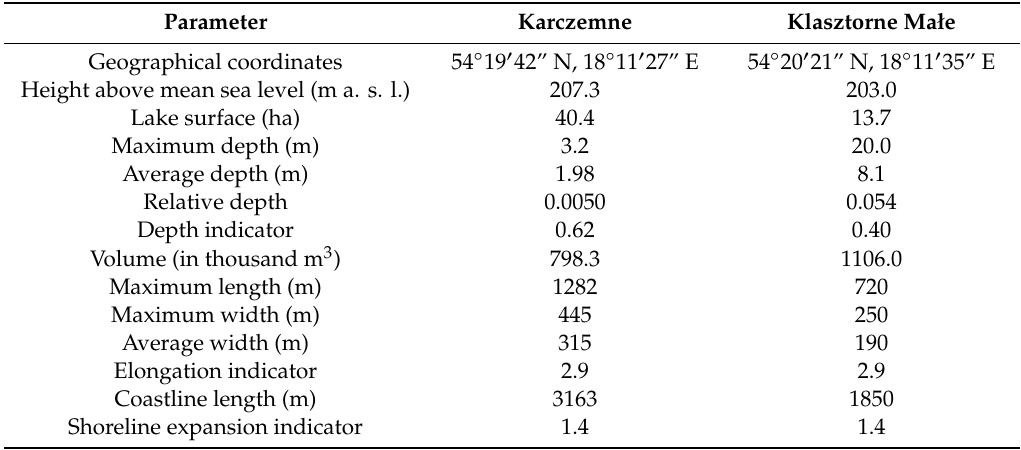
Table 1. Morphometric parameters of Karczemne and Klasztorne Małe lakes. Parameter Karczemne Klasztorne Małe Geographical coordinates 54 ◦ 19 (cid:48) 42” N, 18 ◦ 11 (cid:48) 27” E Height above mean sea level (m a. s.